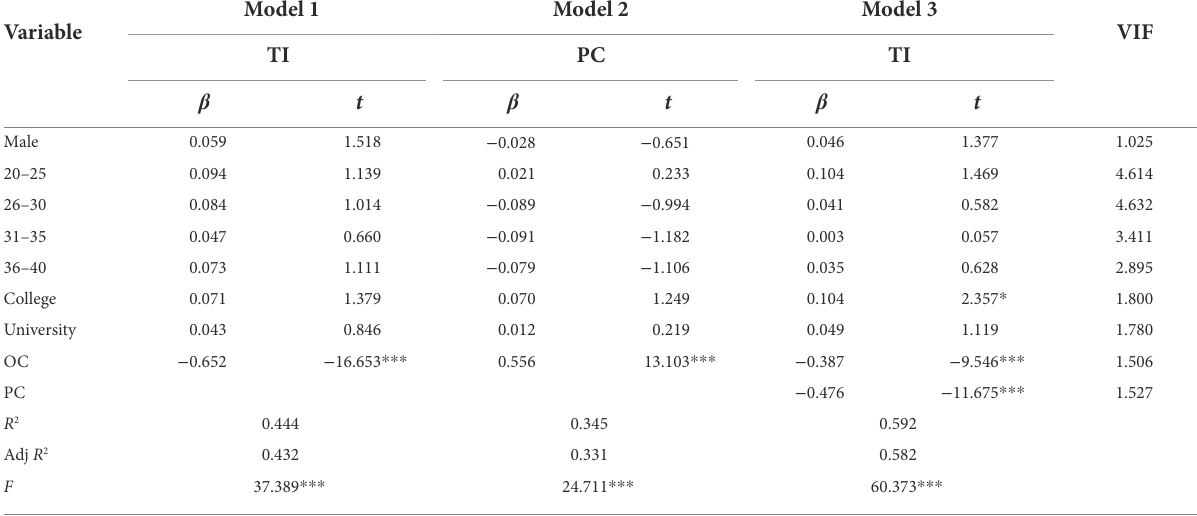
TABLE 2 Mediating effect of psychological capital on the relationship between organizational commitment and turnover intention.